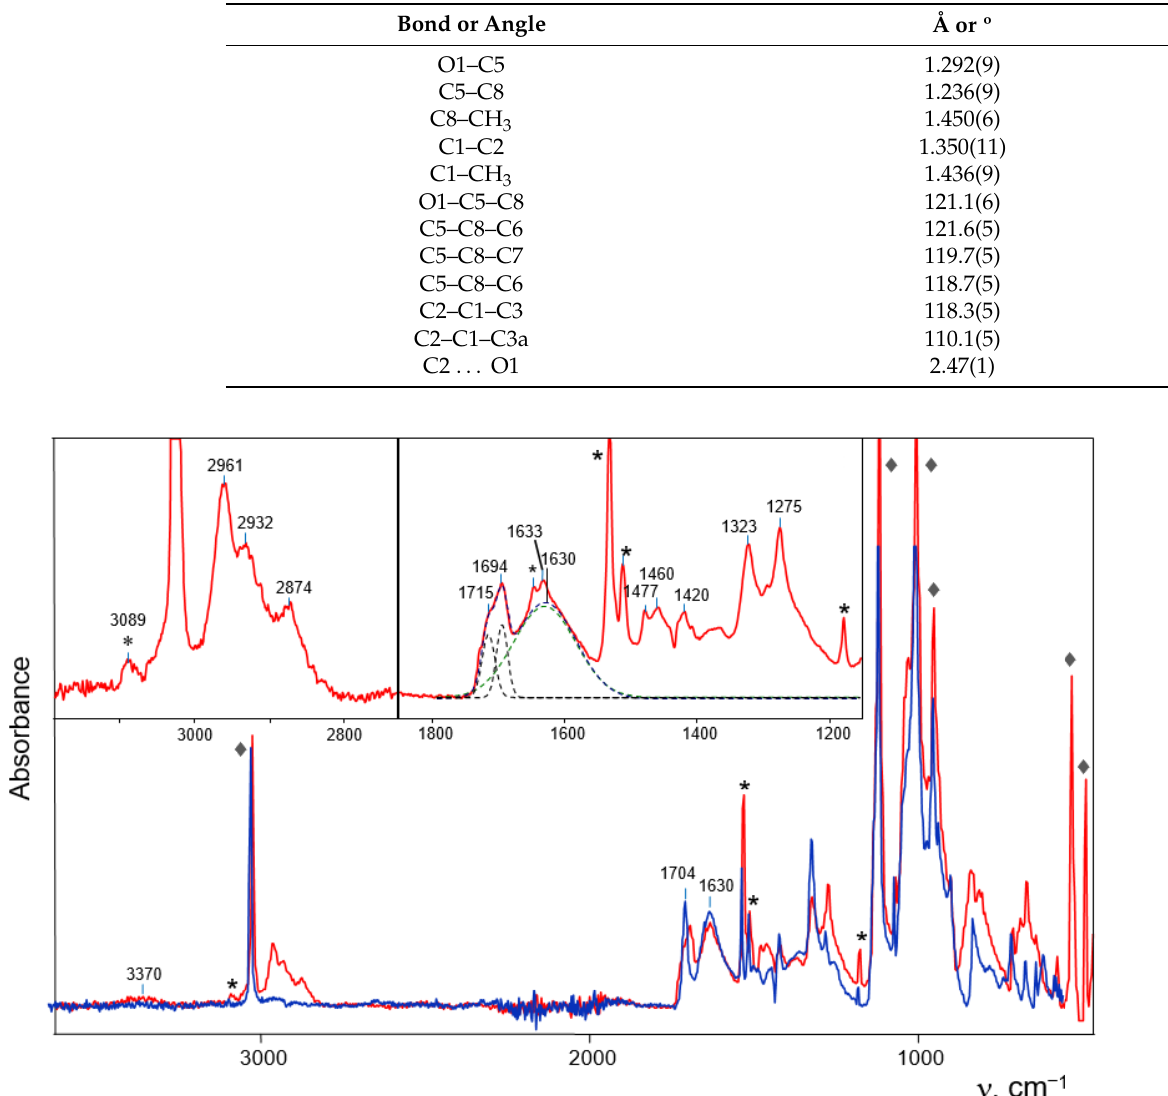
Figure 6. ATR IR spectra (with ATR correction) of crystals of (C 4 H 7+ ·· C 4 H 7 OH)(Cl 11 − ) (IIa, red) and (C 3 H 5+ ·· C 3 H 5 OH)(Cl 11 − ) (IIb, blue). Characteristic absorption bands of the C 6 HF 5 inclusion molecule are indicated by asterisks, and the strongest absorption bands of the (Cl 11 − ) anion are marked with . The dotted line shows separation of contours of the bands of stretching C=C vibrations (in the inset).